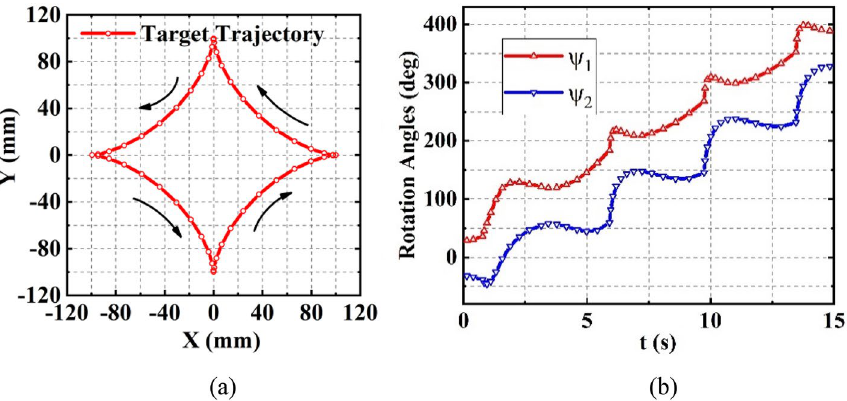
Figure 7. ( a ) The given asteroid target trajectory, ( b ) the inverse solutions to the orientations of GM 1 and GM 2